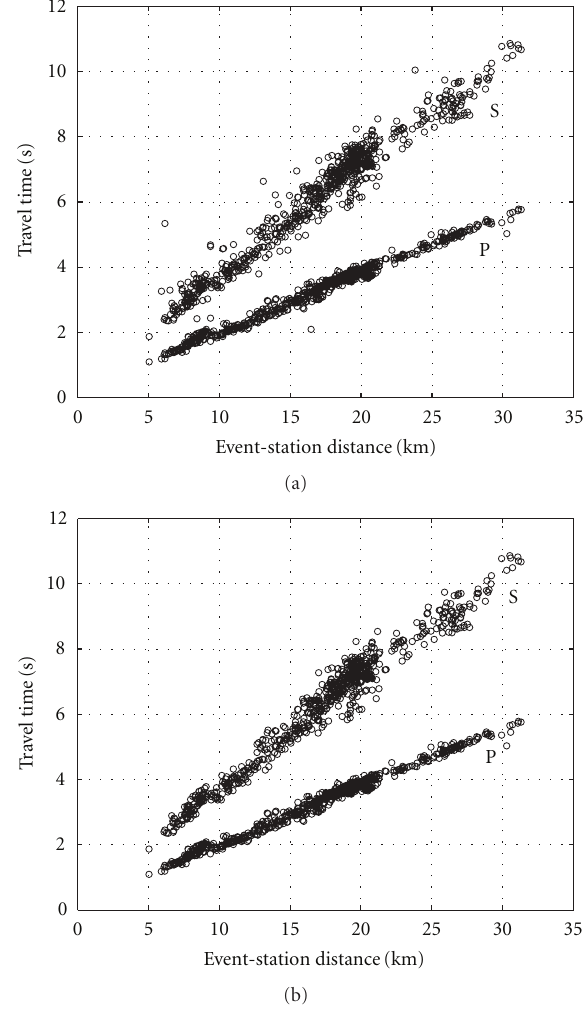
Figure 2: Travel time variations of the station LYS with change of the event-station distances before (a) and after (b) removal of abnormal travel